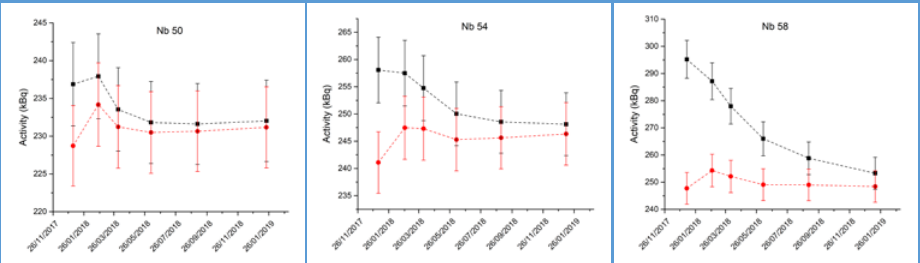
Fig. 5. Activity of 93m Nb at the reference date for 3 discs without (black) and with (red) correction of the fluorescence of impurities (Ta impurities 0.3, 4 and 19.6